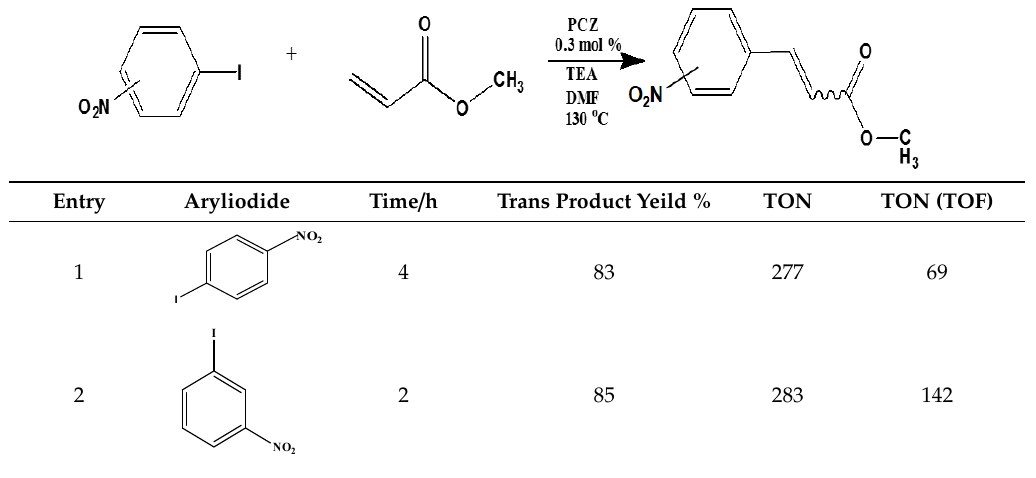
Table 6. Influence of olefin electronics on the yield and progression of reactions.